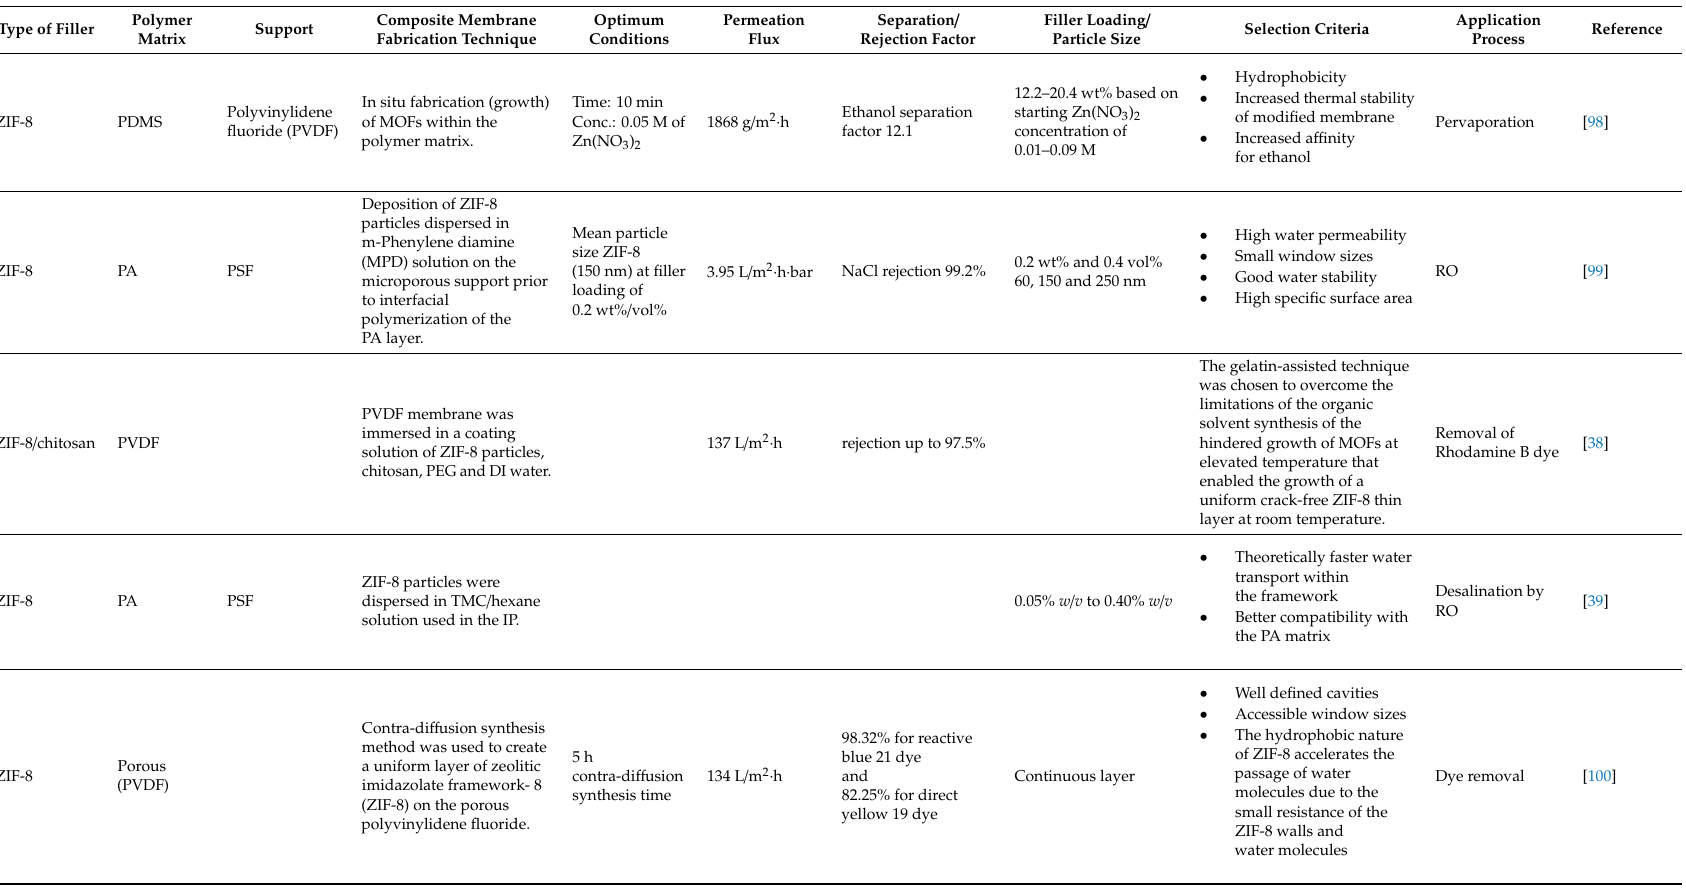
Table 2. Properties and fabrication conditions of some successful prepared MOFS-mixed matrix